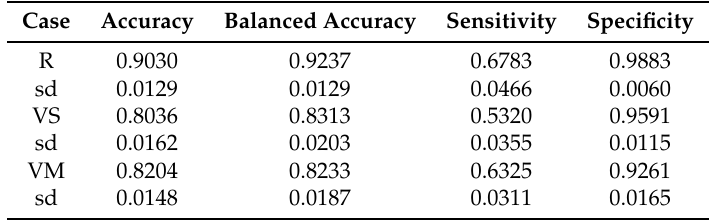
Table 4. Results of comment classification. Standard deviation (sd) is also shown.